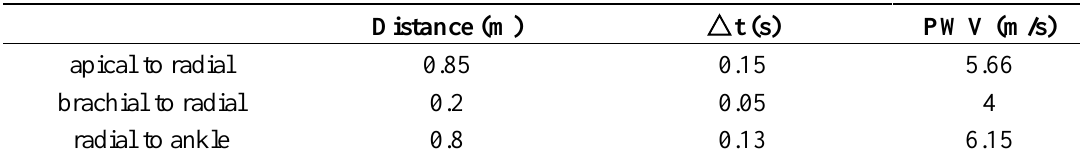
Table 3. The apical to radial, brachial to radial and radial to ankle human body